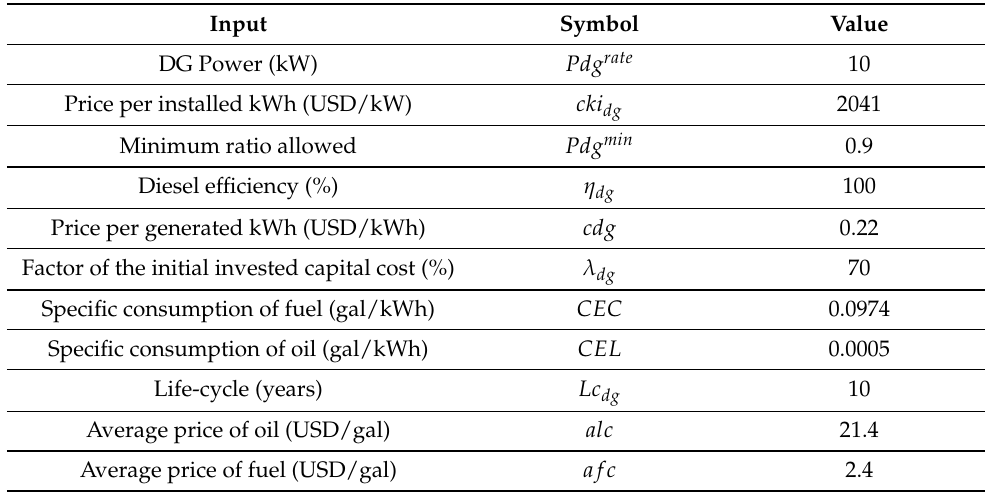
Table 4. Input parameters of the Diesel